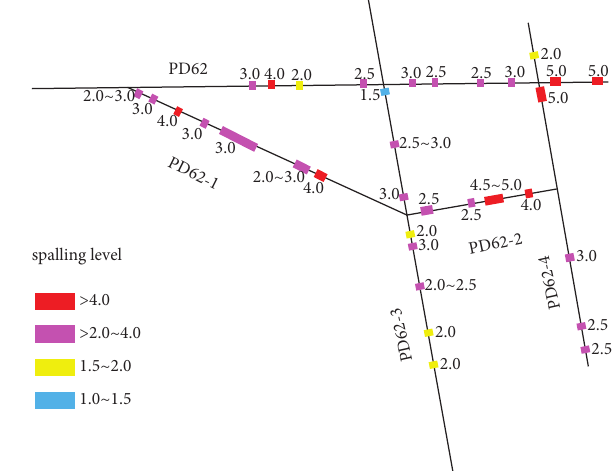
Figure 2: Spalling features of the tunnels on the right bank.